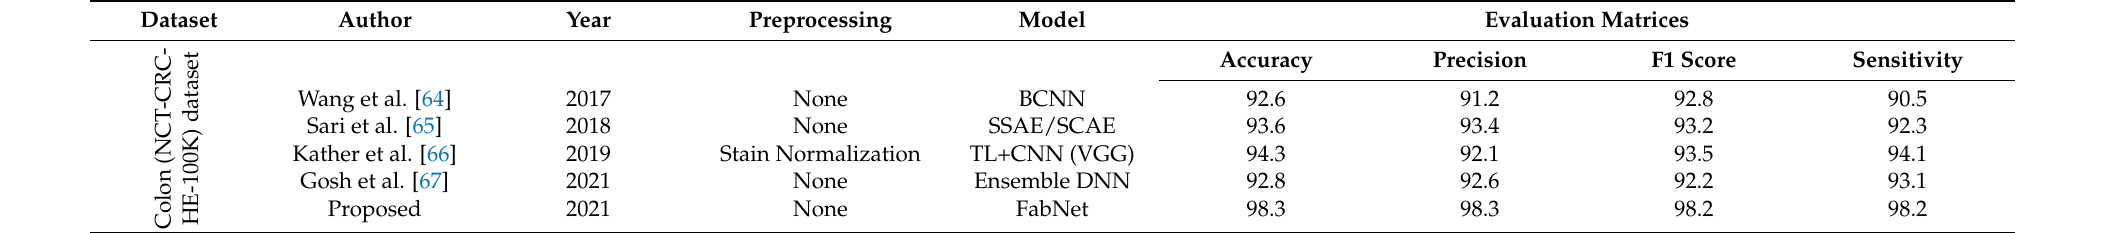
Table 10. A comparison of FabNet performance with existing studies on Colorectal histology